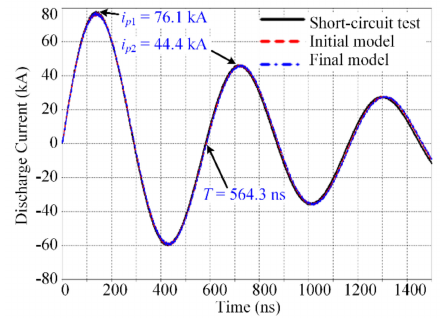
Figure 13. Simulated and measured short-circuit current waveform of a